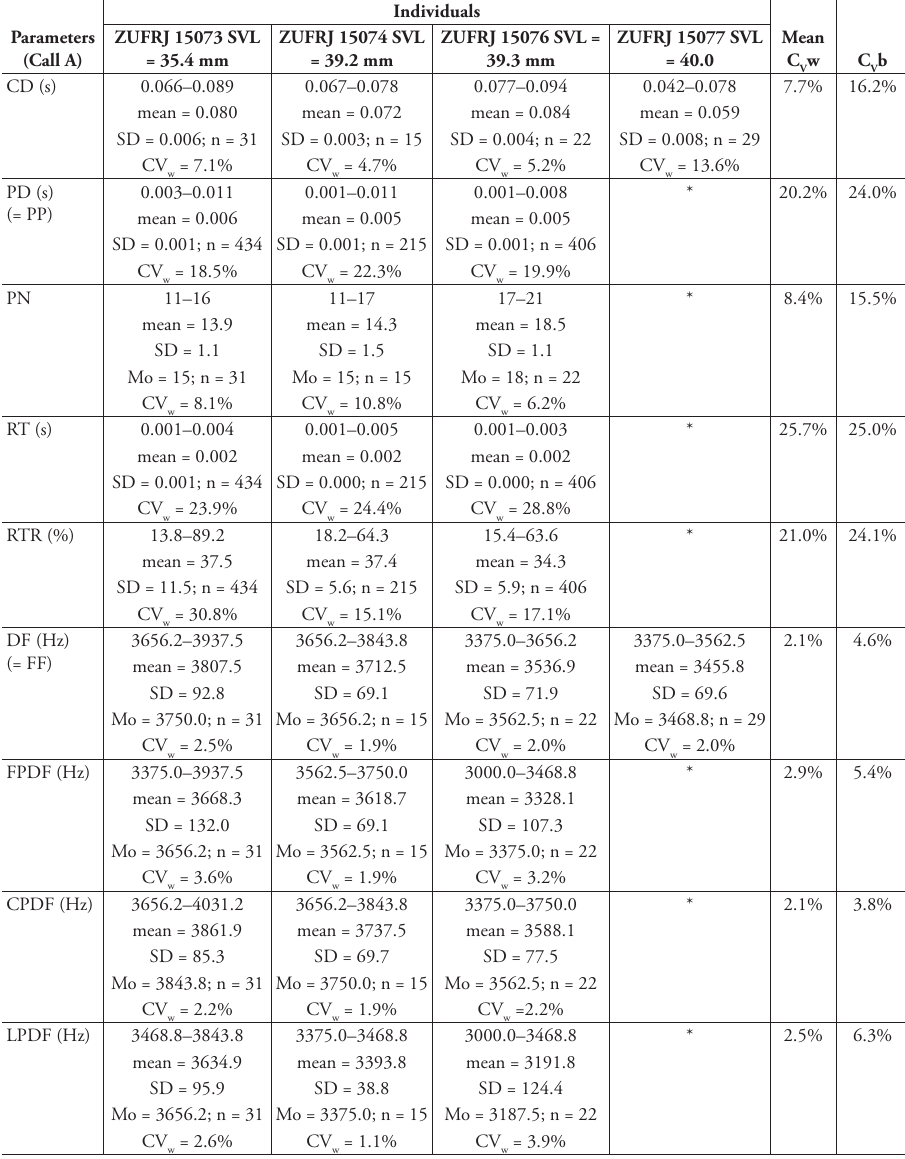
Table 1. Call parameters for the call A of each recorded individual of Boana latistriata . Values are given as range, mean, standard deviation (SD), mode (Mo; when applicable) and sample number (n). Abbrevia- tions: SVL, snout-vent length; CV , within-individual coefficient of variation; CV , between-individual w b coefficient of variation; CD, call duration; DF, dominant frequency; FF, fundamental frequency; PD, pulse duration; PP, pulse period; RT, pulse rise time; RTR, proportion of pulse rise time in relation to pulse duration; FPDF, first pulse dominant frequency; CPDF, central pulse dominant frequency; LPDF, last pulse dominant frequency; PN, pulse number. * All instances of call A of this individual presented some pulses fused in a pulsatile, which made it impossible to measure pulse parameters